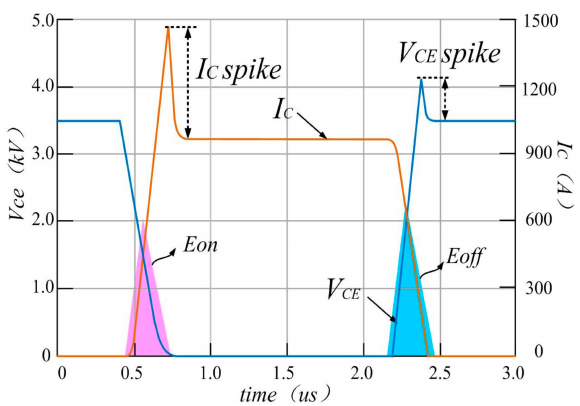
Figure 2. Waveforms of the IGBT switching simulation.